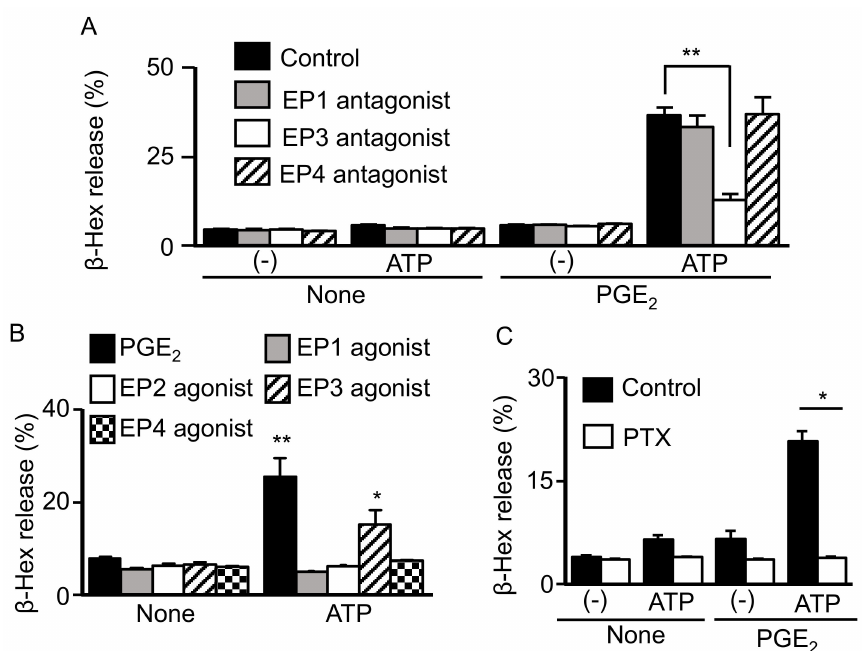
Figure 2. Involvement of EP3 receptor activation in the synergistic e ff ect of prostaglandin (PG)E 2 and ATP on mast cell (MC) degranulation. ( A ) Bone marrow-derived MCs were preincubated with a vehicle, ONO-8713 (EP1 antagonist), ONO-AE3-240 (EP3 antagonist), and ONO-AE3-208 (EP4 antagonist)